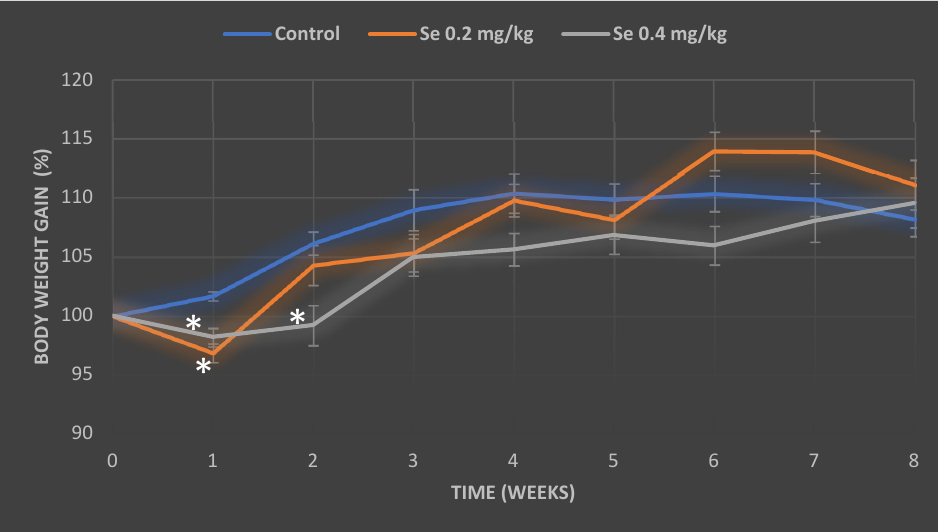
Figure 1. Time course of body weight gain of the control group mice and the mice orally treated with Na 2 SeO 3 solution for 8 weeks. The medium weight gain in the groups was expressed as a percentage, and the initial weight of the mice in each group was equated to 100%. The model of selenium exposure to mice is described in the Methods section. The data were obtained by measuring the body weight of 16 mice in each group. *—differences are statistically significant in comparison to the control group; p <